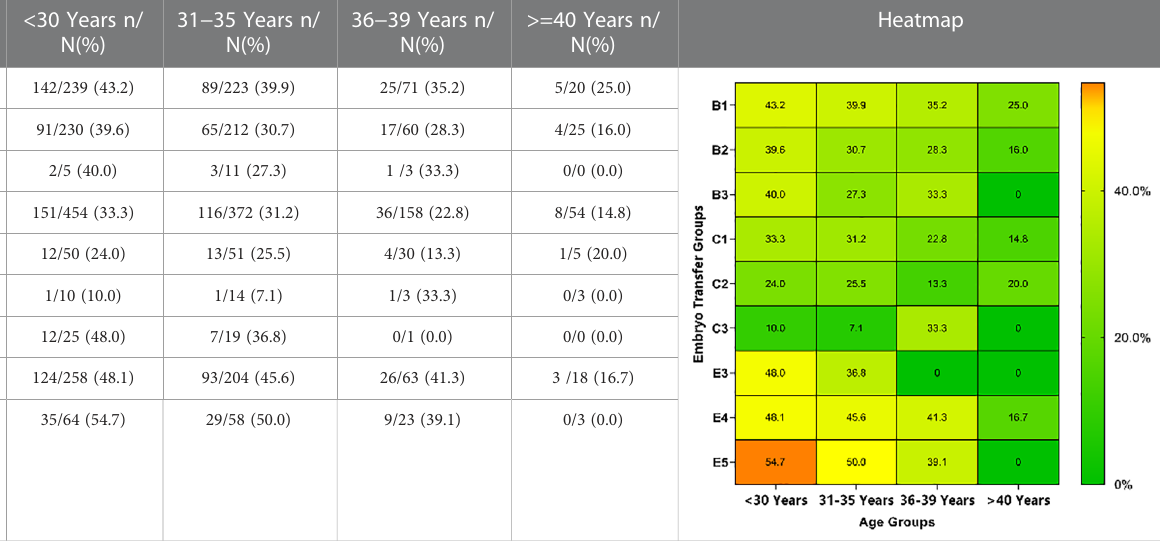
TABLE 6 Multiple birth rates of embryo transfer groups based on maternal age.